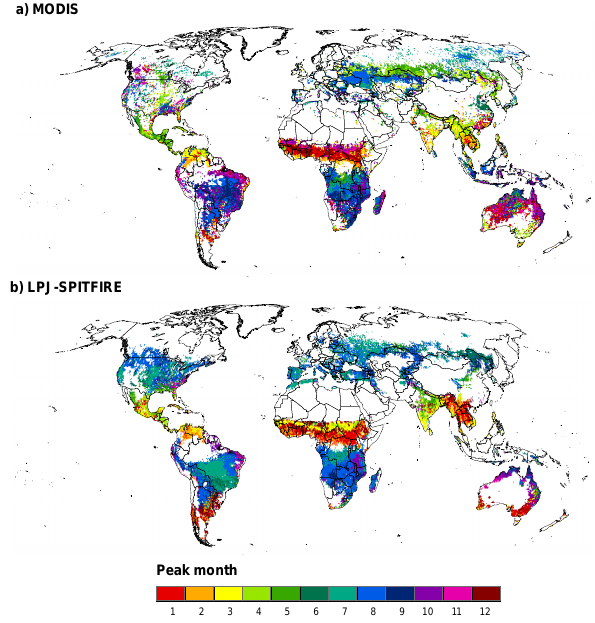
Fig. 5. (a) Observed (MODIS) and (b) simulated fire peak month, November 2000 to October